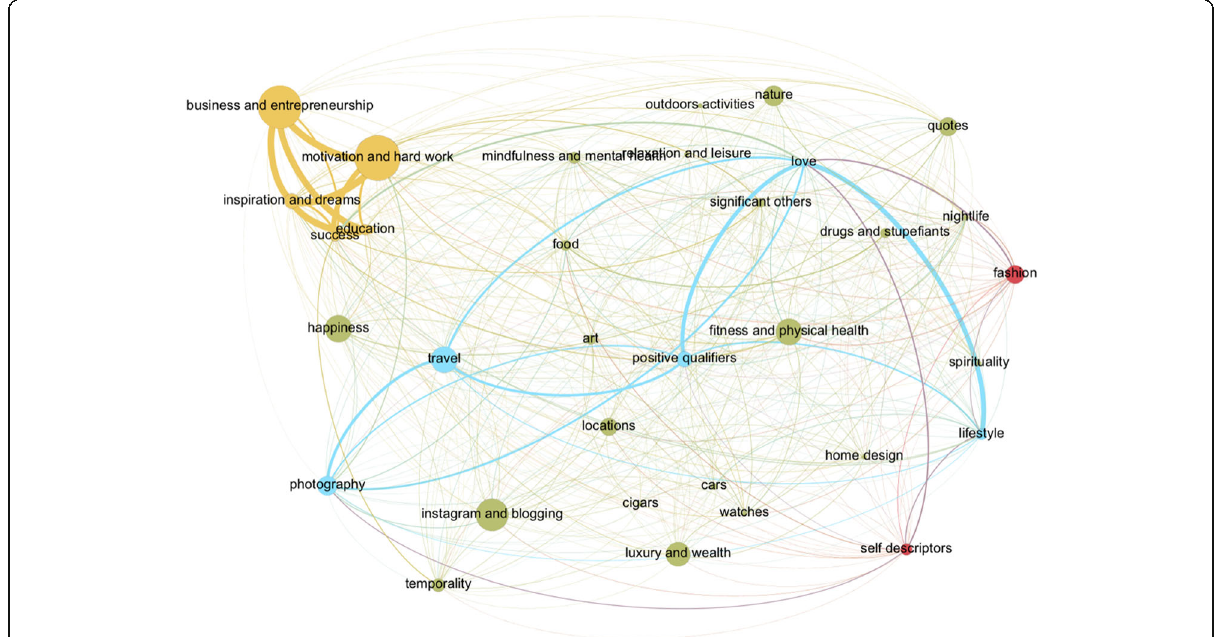
Fig. 1 Plot illustrating the relationships between thematic clusters of